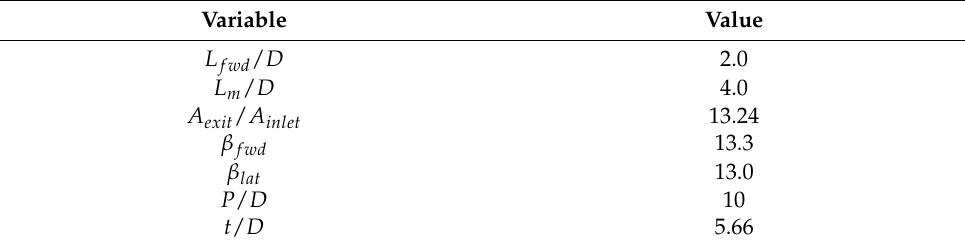
Figure 1. Geometry shape of the reference fan-shaped cooling hole [13]. Table 1. Reference fan-shape cooling hole dimensions